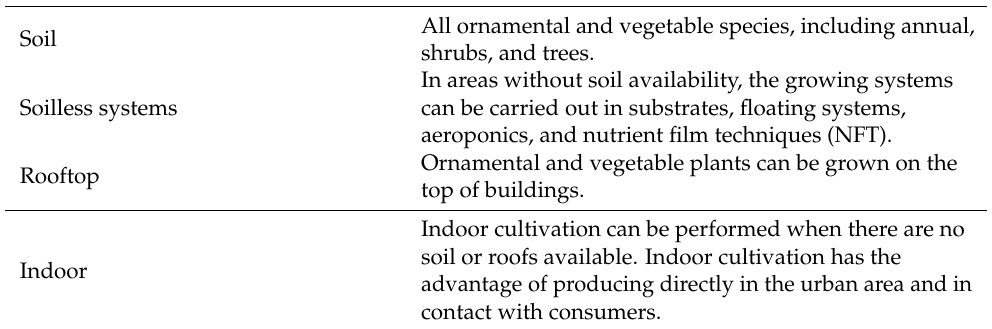
Table 1. Cultivation of plants in urban environments and the possible growing systems that can be